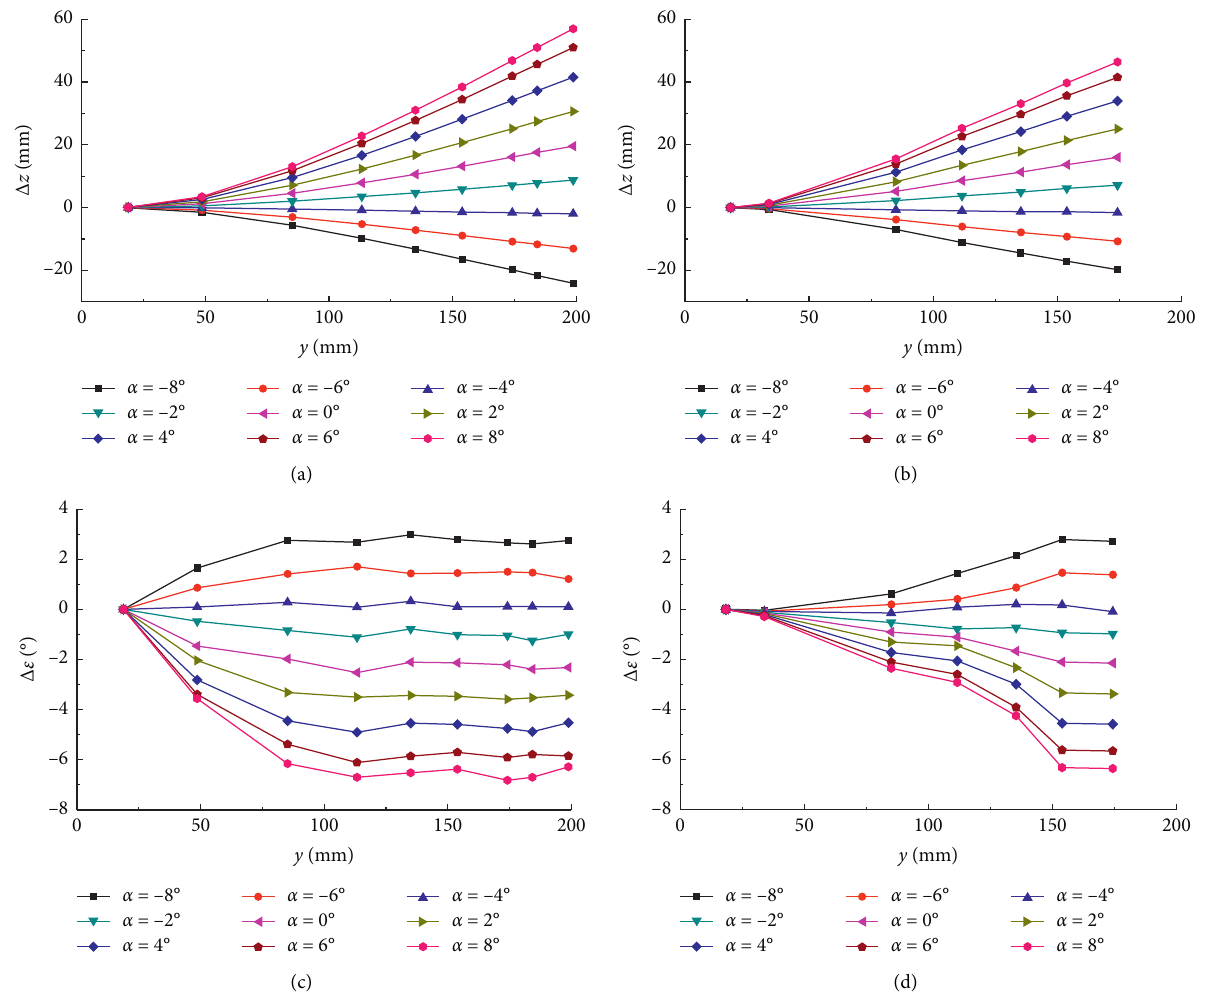
Figure 7: Geometry deformation characteristics of wing. (a) Δ z ∼ α (front wing). (b) Δ z ∼ α (rear wing). (c) Δ ε ∼ α (front wing). (d) Δ ε ∼ α (rear